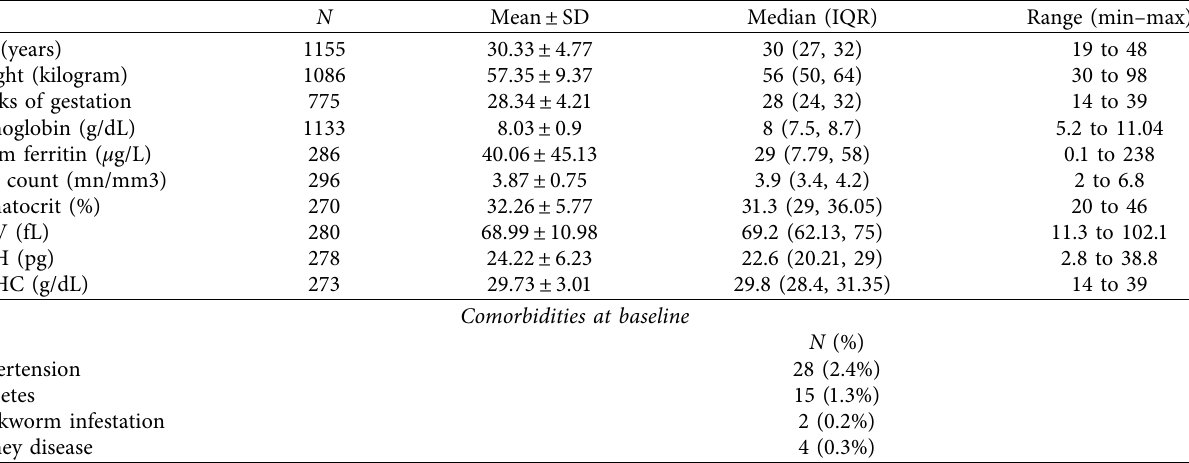
Table 2: Subject characteristics at